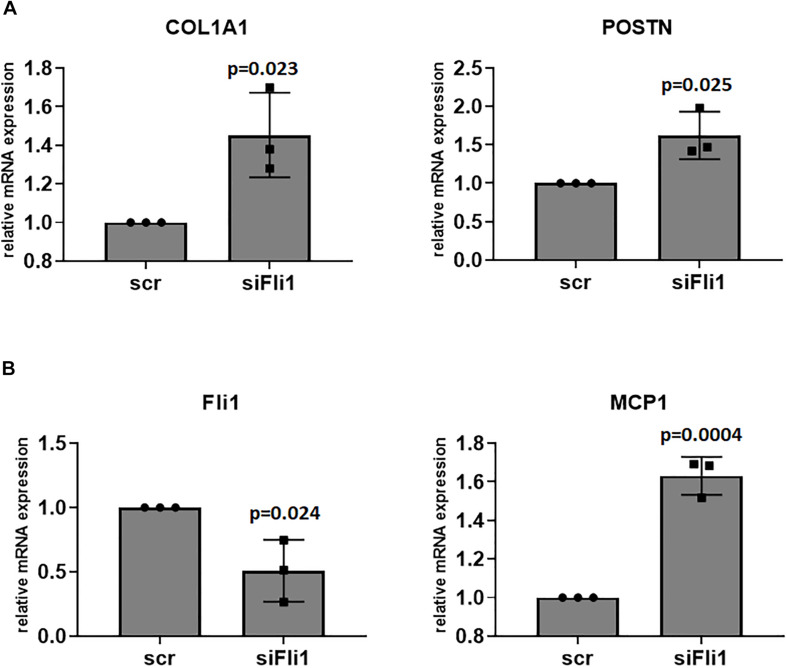
(A) Conditioned media from Fli1 deficient Mø has profibrotic effects on fibroblasts. Confluent, serum starved human dermal fibroblast were treated with conditioned media from scr and siFli1 treated THP1 cells, and after 6 h cell pellets were collected and mRNA levels of Collagen (COL1A1) and POSTN (periostin) were analyzed via RT-PCR. (B) Downregulation of Fli1 in fibroblasts induces CCL2/MCP1 mRNA levels. Confluent, serum starved human dermal fibroblast were treated with scr and siFli1 for 48 h then cell pellets were collected and mRNA levels of CCL2 were analyzed via RT-PCR. Mean ± SD.